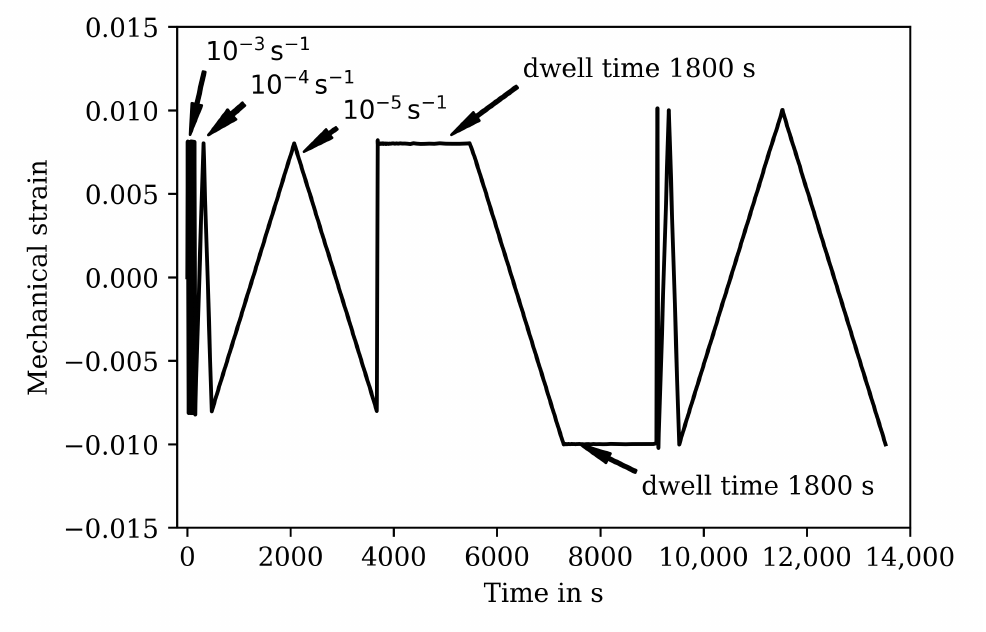
Figure 1. Mechanical strain over time for the complex cycles of the CLCF tests with different strain rates and dwell